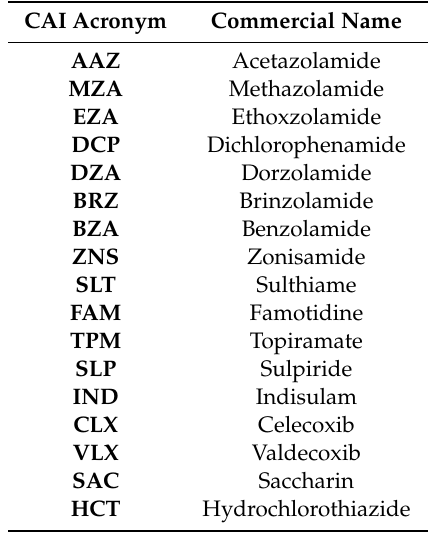
Table 2. Acronyms and commercial names of the CAI clinically used drugs.